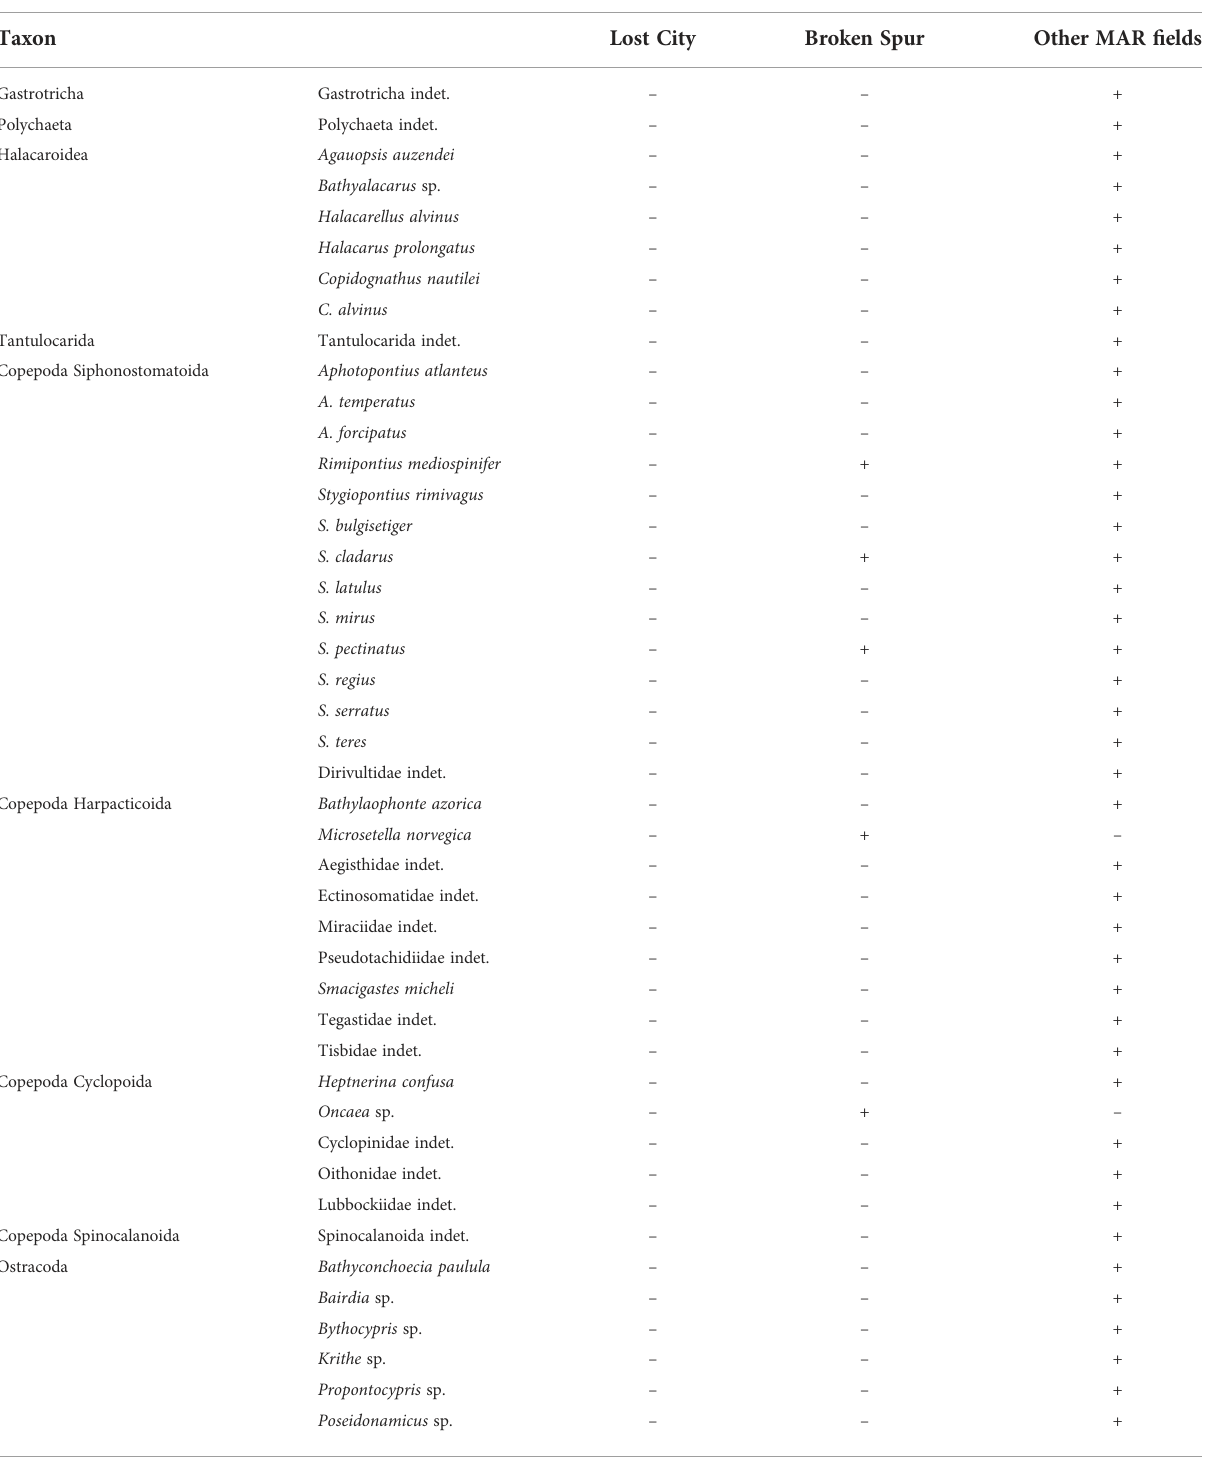
TABLE 2 Meiofaunal taxa reported from the hydrothermal vent fi elds in the Polish contract area (Lost City, Broken Spur) and elsewhere on MAR; A) non-nematode taxa; B) nematode taxa (data from Gebruk and Mironov, 2006; Flint, 2007; Ivanenko et al., 2011; Tchesunov, 2015; Zeppilli et al., 2015; Sarrazin et al., 2015; Zeppilli et al., 2019; Spedicato et al., 2020); +, taxon recorded; -, taxon not recorded. A